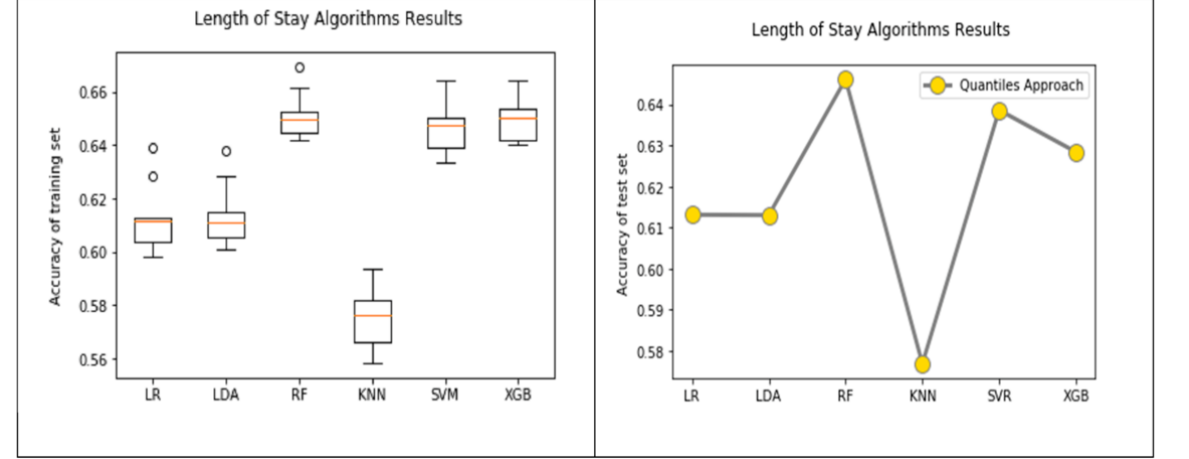
Figure 8. Comparison of the length of stay model results using the quantiles approach on the training set (left) and the test set (right). LR: logistic regression; LDA: linear discriminant analysis; RF: random forest; KNN: k-nearest neighbor; SVM: support vector machine; XGB: extreme gradient